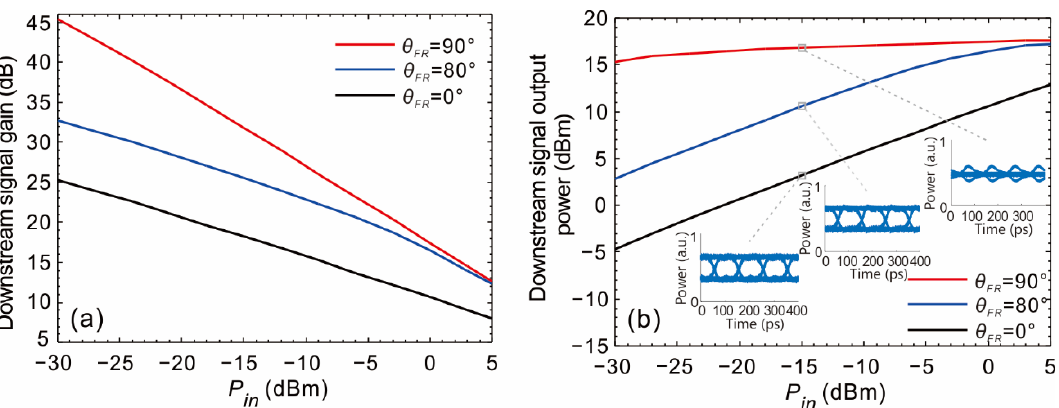
Figure 2. ( a ) The gain saturation curves of the downstream signal at different Faraday rotation angles. ( b ) The downstream signal output power versus the input power at different Faraday rotation angles. The inlets show the erased eye-diagrams when the input power is −15 dBm. Note that the output powers and eye-diagrams are extracted from the suppressed downstream signal before entering the EAM.